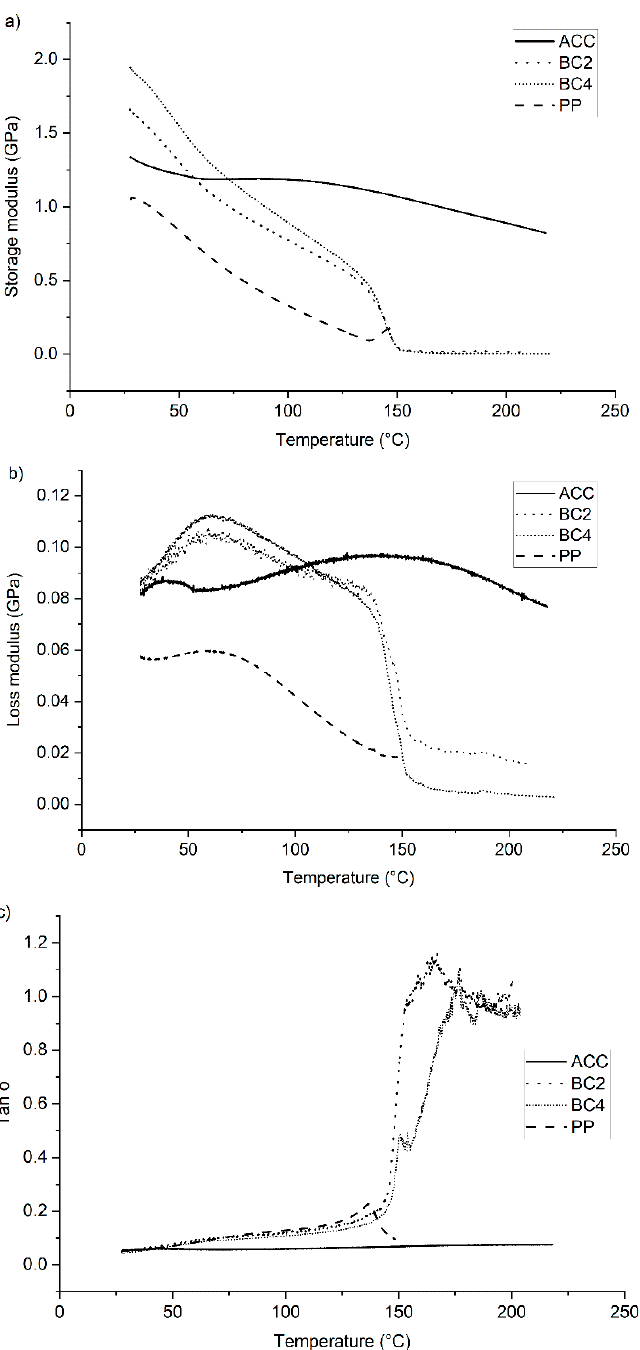
Figure 8. Results of the DMA: ( a ) storage modulus (GPa), ( b ) loss modulus (GPa) and ( c ) tan δ for all-cellulose composites (ACC), biocomposites (BC2 and BC4) and polypropylene (PP).